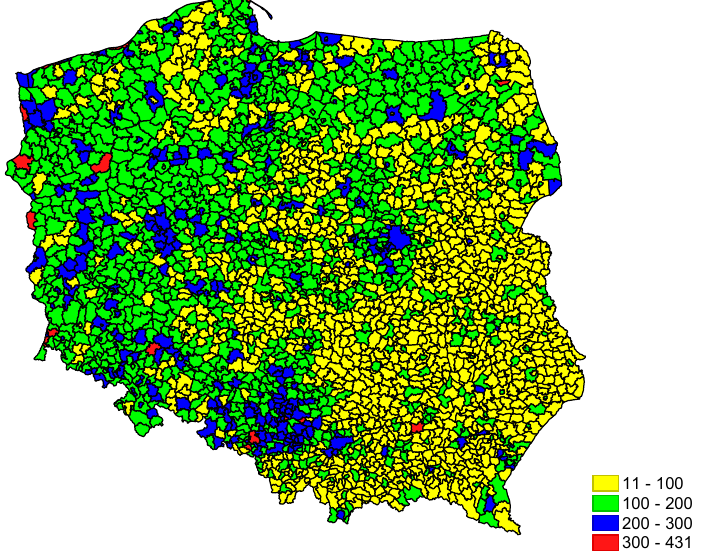
Figure 2. Amount of generated waste from households in kg · (per · year) − 1 on the territory of municipalities in Poland in 2013–2016.